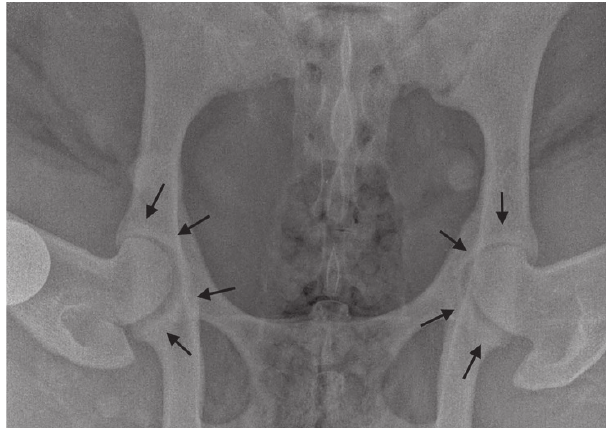
Figure 4 | Image showing a ventrodorsal radiographic view of the hip joints of clone 2260. Both femoral heads appear normally seated within the acetabulae, with minimal remodelling and no obvious osteophytosis. A mild increase in bone density (white) is evident around both acetabular rims (black arrows), however there is no significant remodelling of the acetabulum or femoral head and neck regions. This sheep therefore has minimal radiographic evidence of osteoarthritis. The circular opacity is a 25mm coin, placed as marker to indicate the right limb.